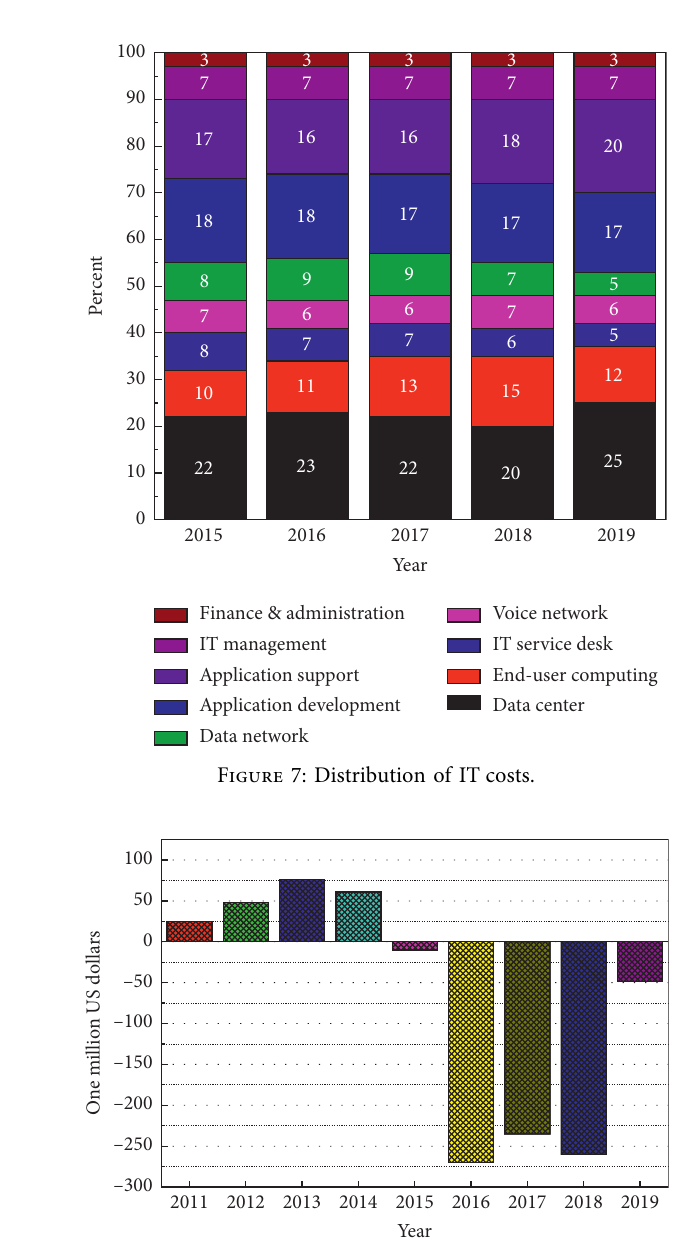
Figure 8: City net profit over the